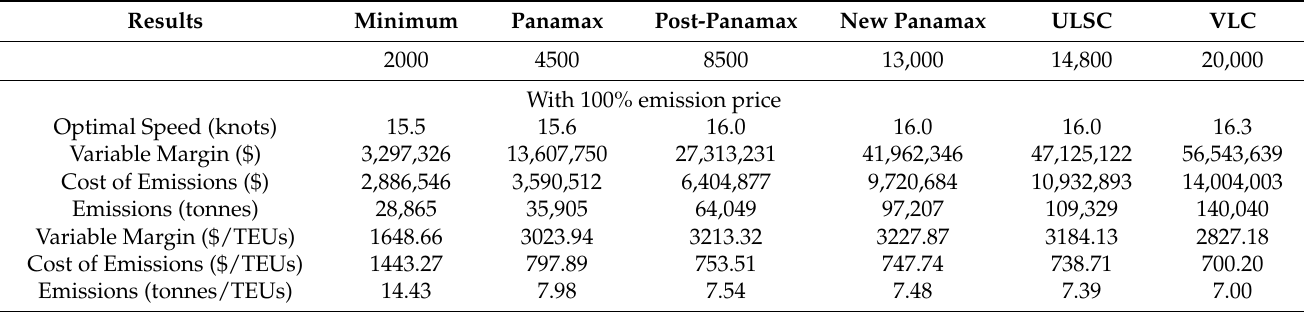
Table 11. Optimal behaviour of selected vessels with a carbon price of